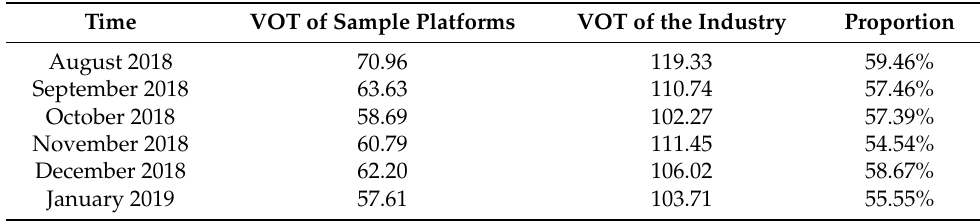
Table 5. The total transaction volume of the sample platforms and the whole industry.